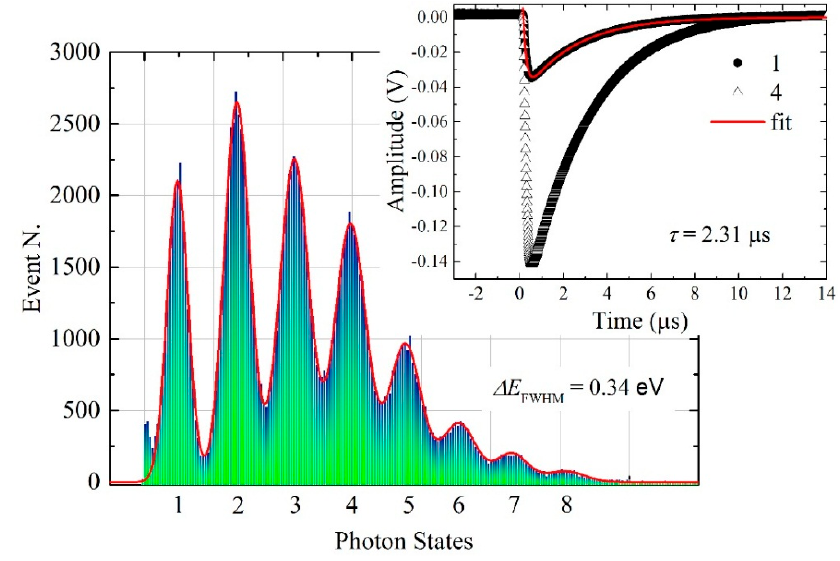
Figure 5. Eight photon states are distinguishable at 1545 nm with an energy resolution of 0.34 eV. The inset shows the single and the four photons averaged pulses; by the pulse fit the response time constant is 2.31 μ s.